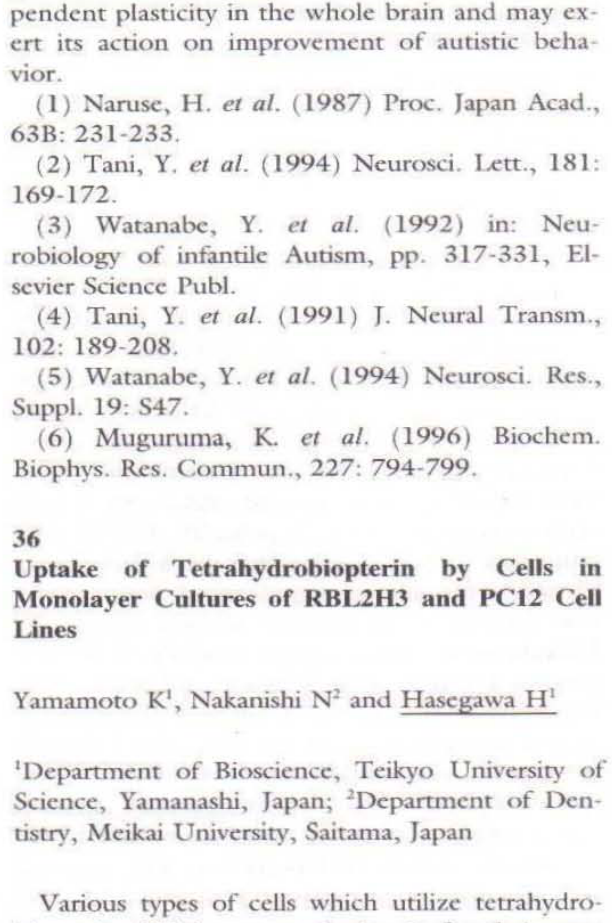
Uptake Monolayer Cultures of RBUH3 and PC I2 Cell